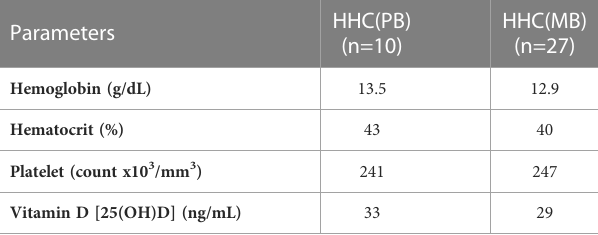
The analysis of Receiver-operating Characteristic Curves (ROC) was carried out for evaluating the accuracy of chemokines and cytokine measurements to classify HHC into categories, according to operational classi fi cation and SNP TLR4 rs1927914 polymorphism. The MedCalc software (version 18.6, Ostend, Belgium) was used for performance analysis. The Area Under the ROC Curve (AUC) was used as an indicator of global accuracy. Signi fi cance was considered at p<0.05. The cut-offs provided by the ROC curve analysis were used to assess the performance indices, including sensitivity (Se), speci fi city (Sp), and likelihood ratio (LR).